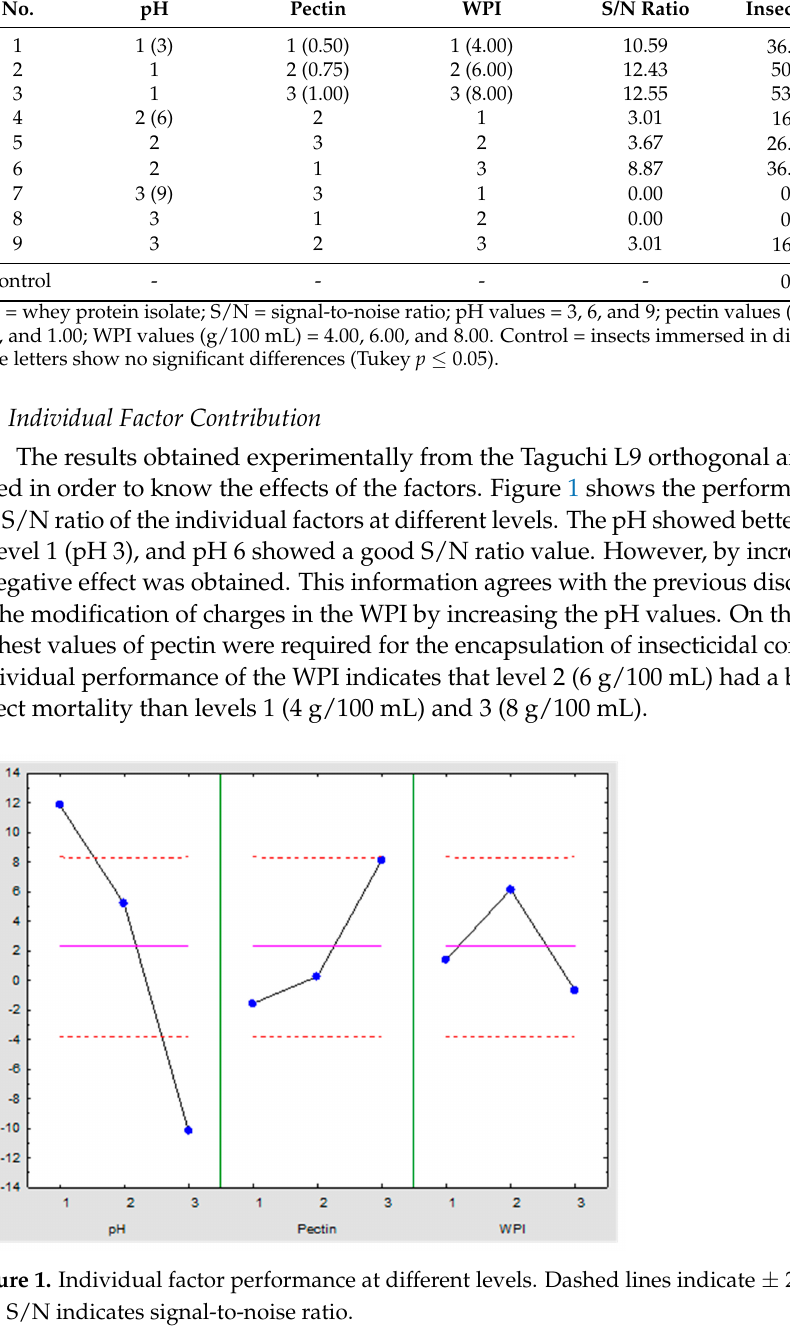
Table 2. Analysis of variance (ANOVA) for the three factors tested. Factor